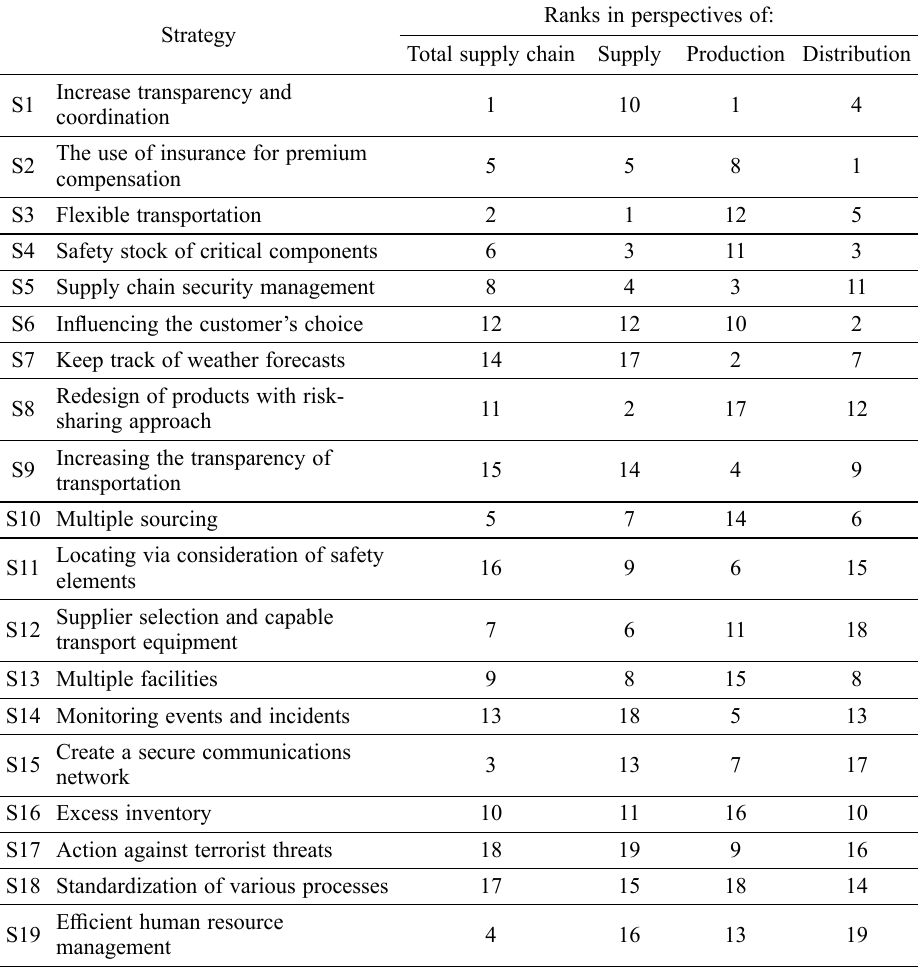
Table 7. The ranks of strategies in 4 different perspectives Ranks in perspectives of: Strategy Total supply chain Supply Production